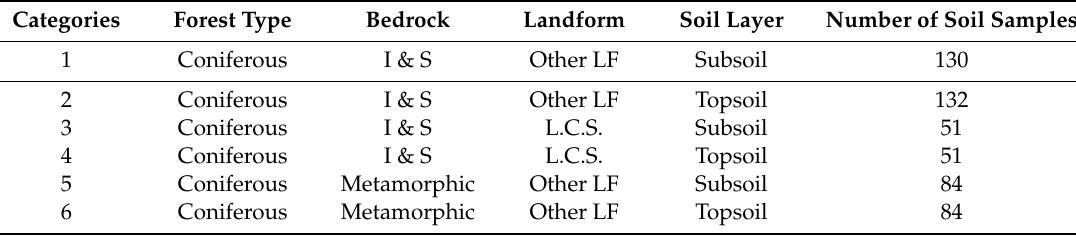
Table 7. Sixteen categories based on forest stand, geological, and topographical